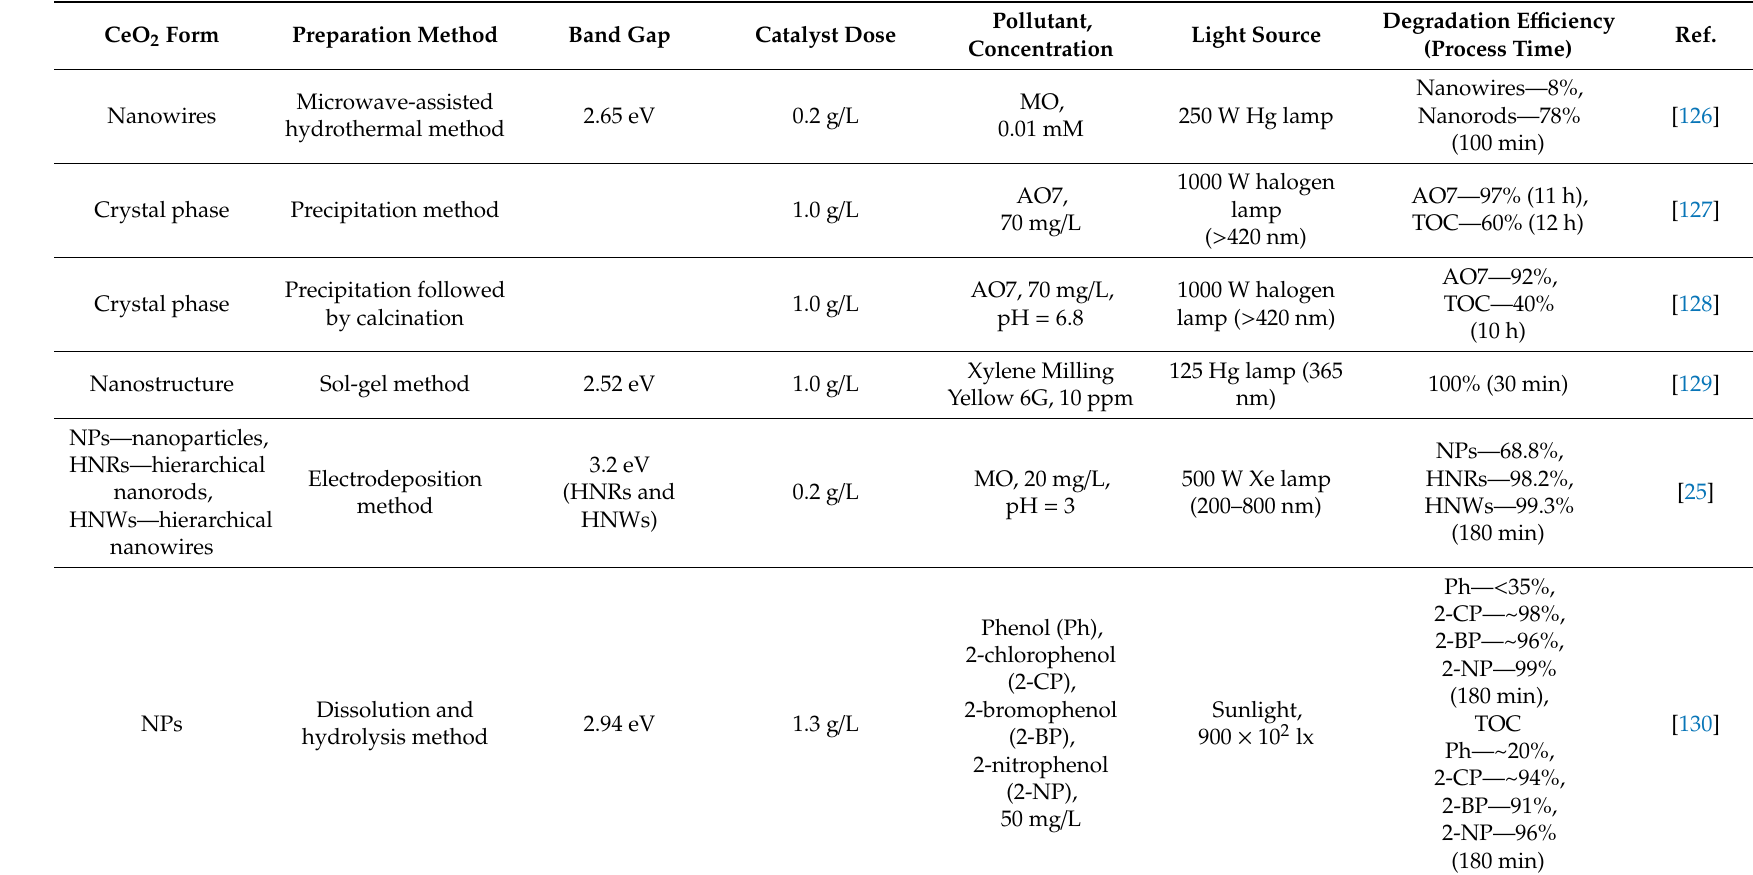
Table 1. Photocatalytic degradation of various pollutants with the application of CeO 2 as a semiconductor photocatalytic